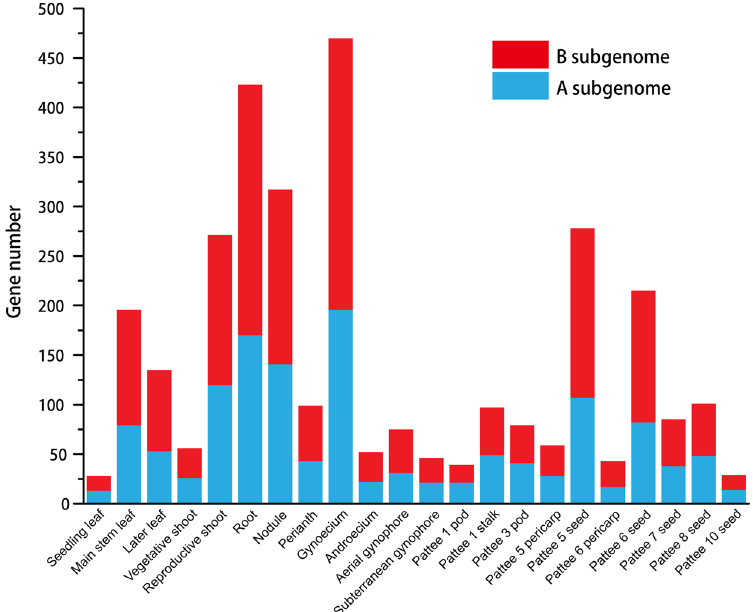
Figure 1. The number of tissue-specific genes in cultivated